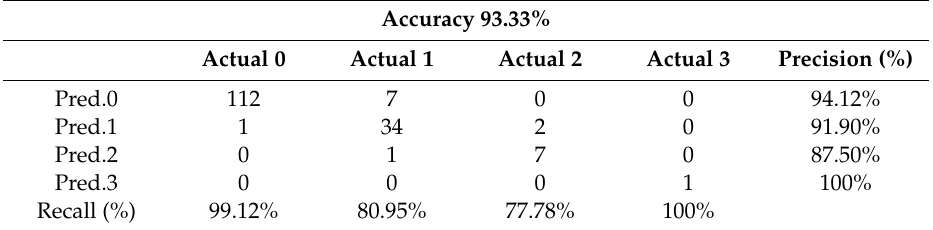
Table 12. Performance in terms of prediction of unseen new data for external